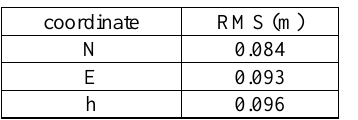
Table 7. RMS of the projection center coordinates